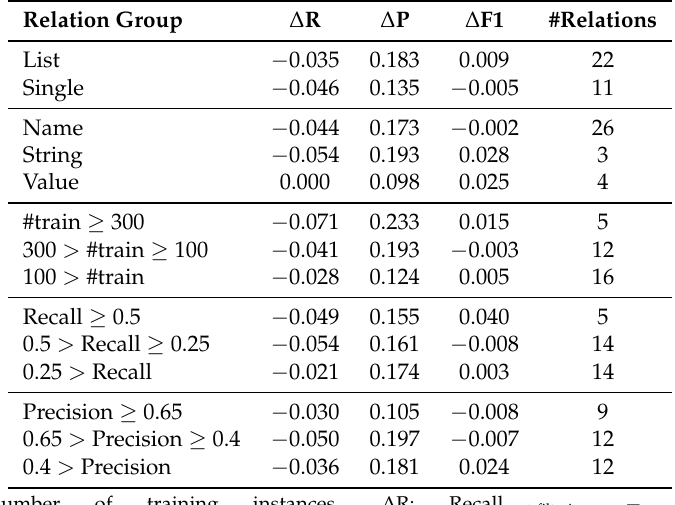
Table 6. Evaluation variation using the TAC KBP 2013 Slot Filling scorer on the test dataset after filtering for different relation groups (Relation